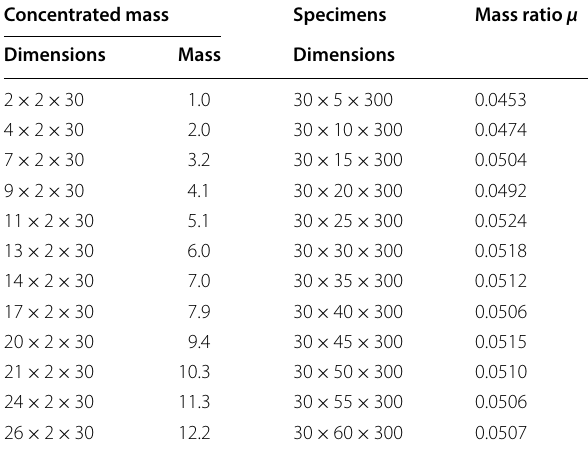
Unit of dimensions: mm, unit of mass: